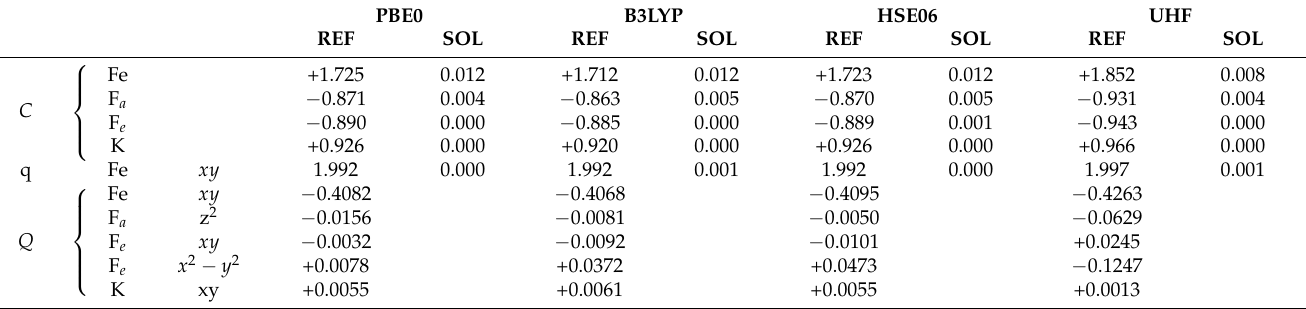
Table 1. Atomic net charges (C) and population of the doubly occupied d orbital (q), evaluated according to a Mulliken analysis. For each considered functional, the first column (REF) gives the net charges computed for the primitive FM cell, and the second column (SOL) the maximum absolute difference observed for all positions (eight for Fe, for example) and for all possible configurations. Numbers are in electrons. The d xy orbital is doubly occupied in the primitive cell; in the various configurations d xz and d yz can be doubly occupied, alternatively. In the bottom five lines the non-null elements of the atomic quadrupole Q tensor of the primitive cell (again computed according to a Mulliken partition of the charge) are reported. F a and F e indicate apical and equatorial F atoms. The quadrupoles are in Bohr 2 . PBE0 B3LYP HSE06